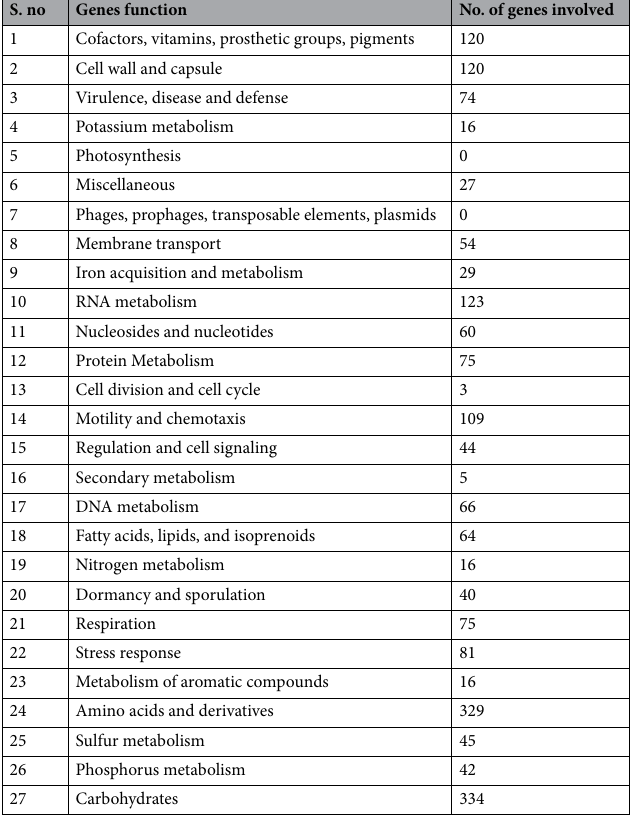
Table 3. Genes identified in the draft genome of Bar D5 involved in cellular and metabolic processes by RAST